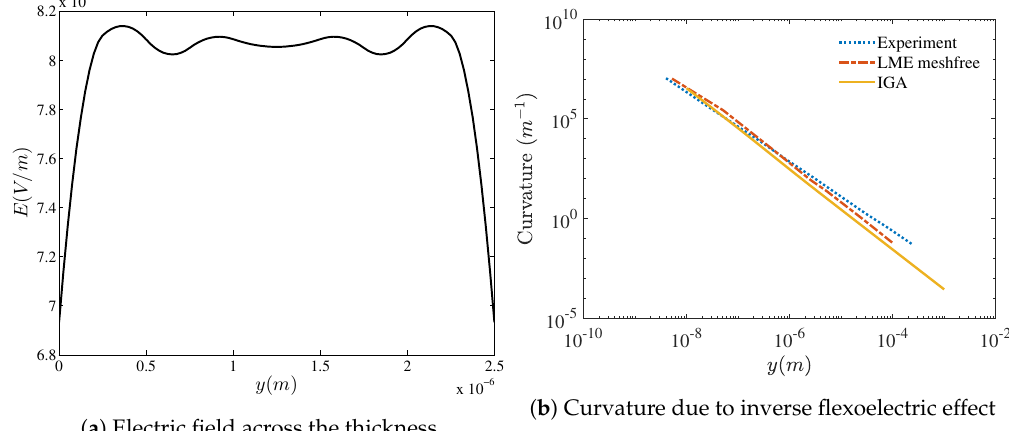
Figure 11. Beam under electrical load.